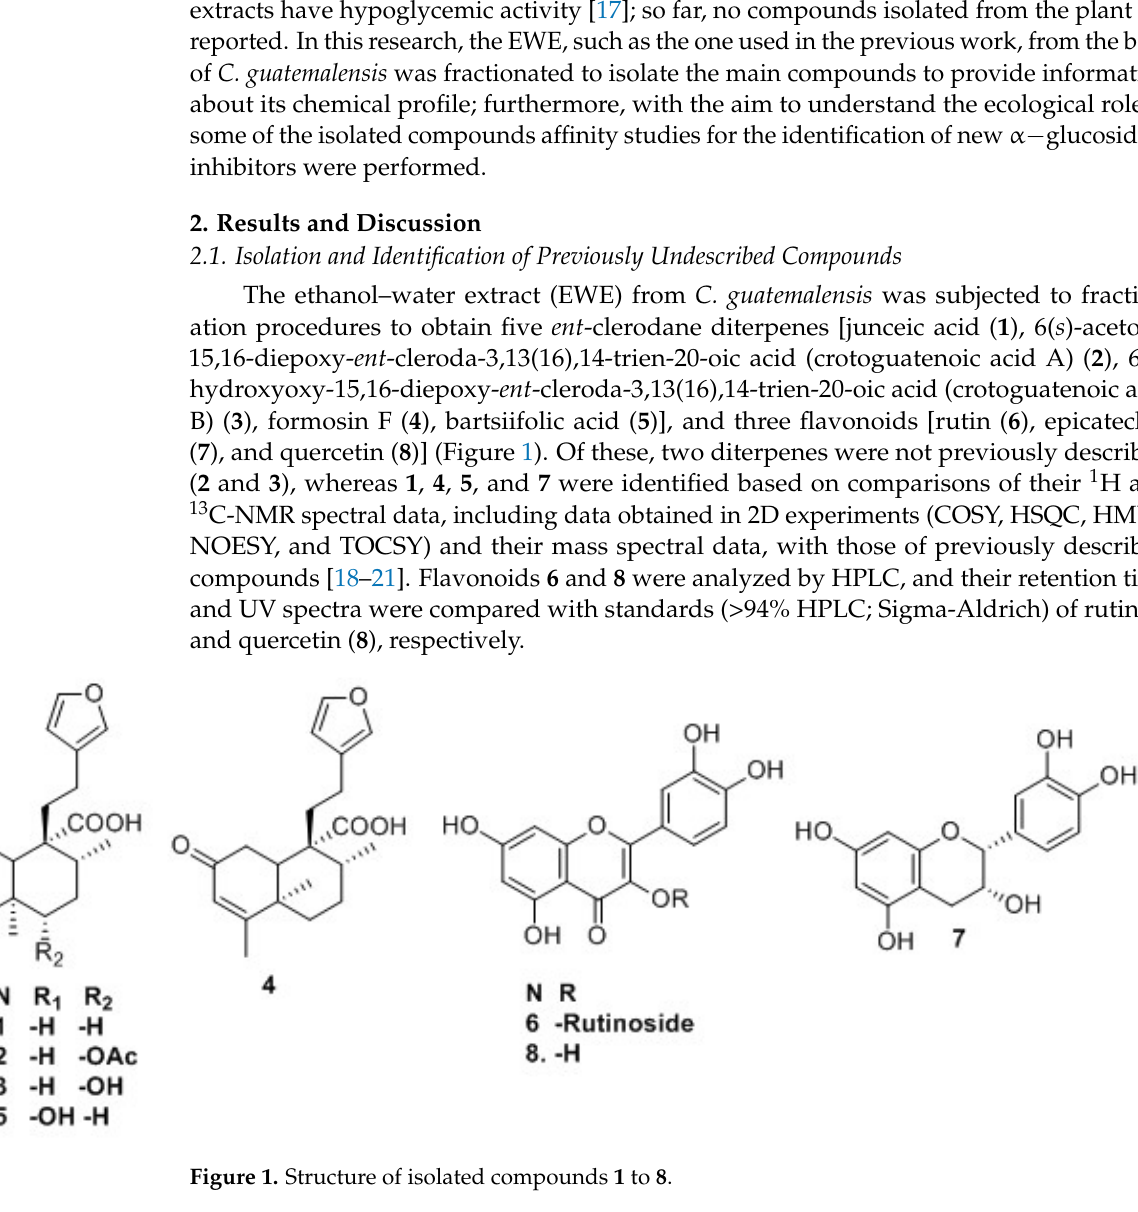
Figure 1. Structure of isolated compounds 1 to 8.